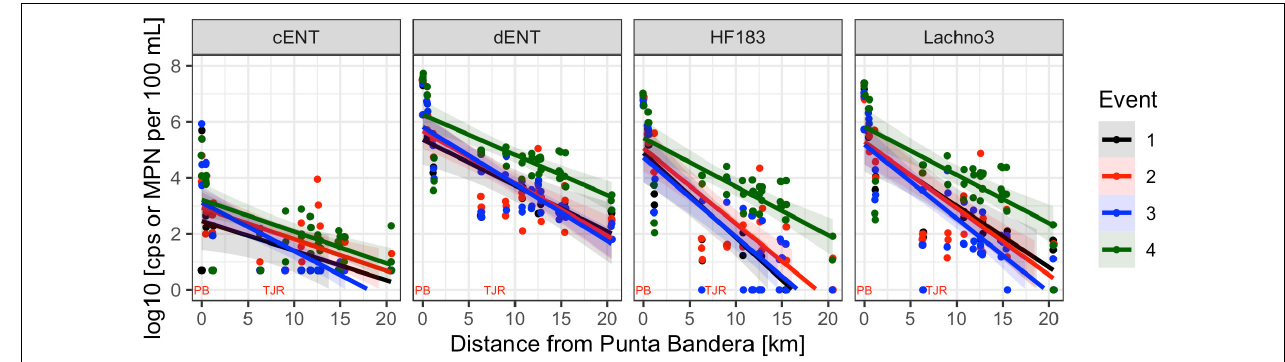
FIGURE 2 | Enterococci by culture (cENT) and ddPCR (dENT) and human marker (HF183 and Lachno3) levels versus distance from the SADB WTP outfall at Punta Bandera. Each event is represented by a different color, with all dates sampled combined per event. On the x -axis location of the SSADB WTP outfall is noted (PB) as is the location of the Tijuana River Estuary